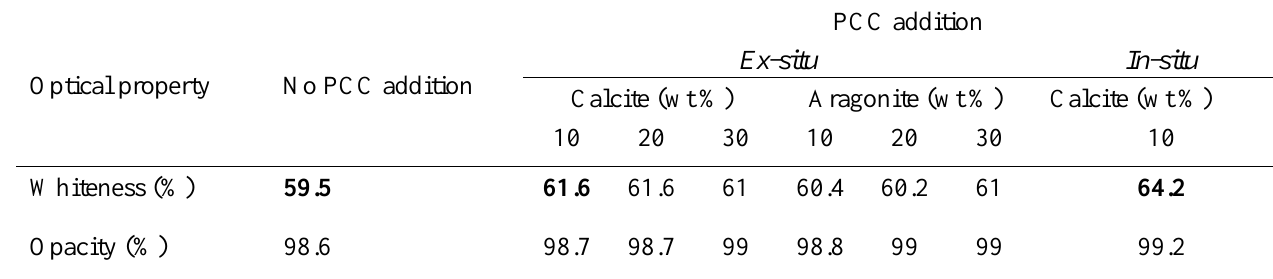
Table 7. Optical properties of the recycled paper made from waste pulp (old newspaper) according to PCC addition and process method ( Ex-situ : paper making process separated from PCC synthesis, In-situ : paper making process combined with PCC synthesis) (modified from Ahn et al . [66]).